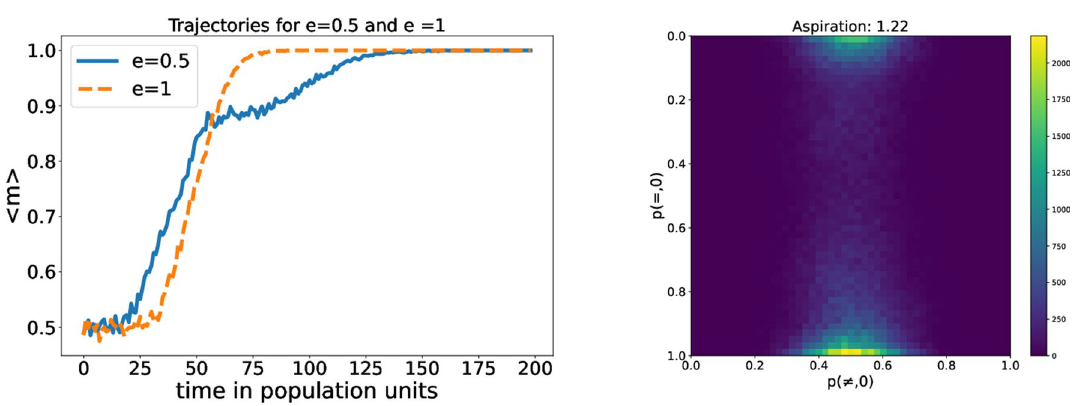
Figure 6. Left: Average coordination ratio for A i = 1.1 and e = 0, 5 or e = 1 . Right: 2D histograms for the probability vectors of the population. A i = 1,